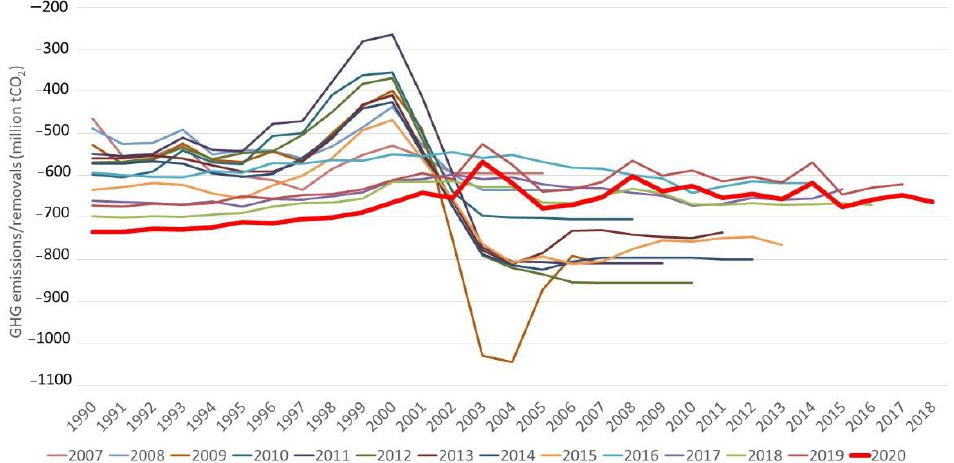
Figure 4. US recalculations of GHGs from forest land remaining forest land (in million tCO 2 /year), generated from United States Environmental Protection Agency data provided in national GHG inventories (2007–2020) [56].